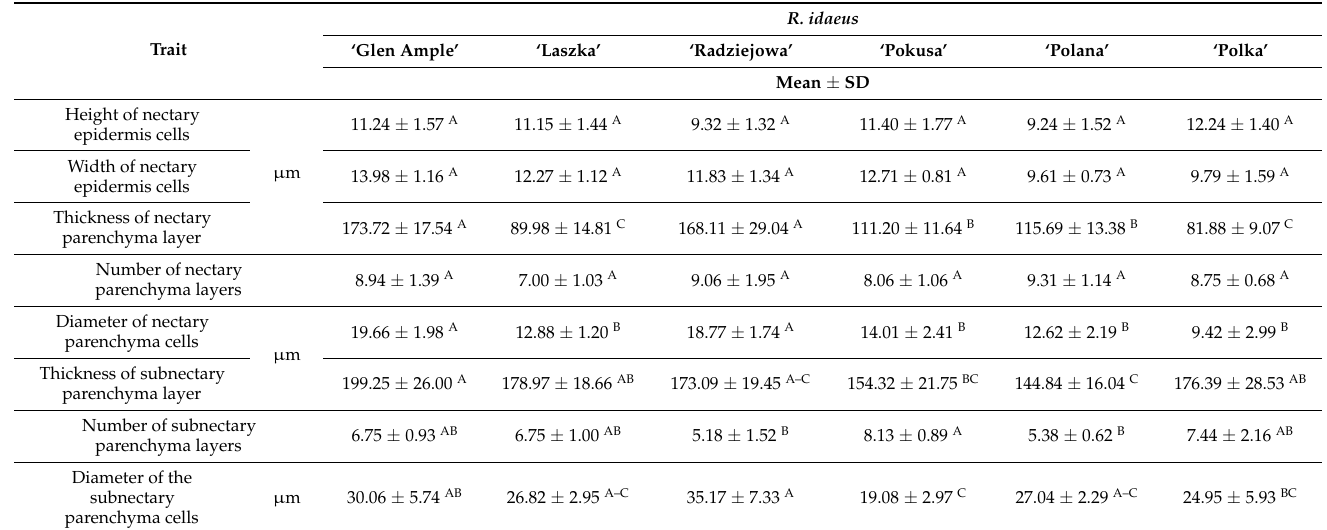
Table 4. Selected anatomical traits of the nectary in R. idaeus